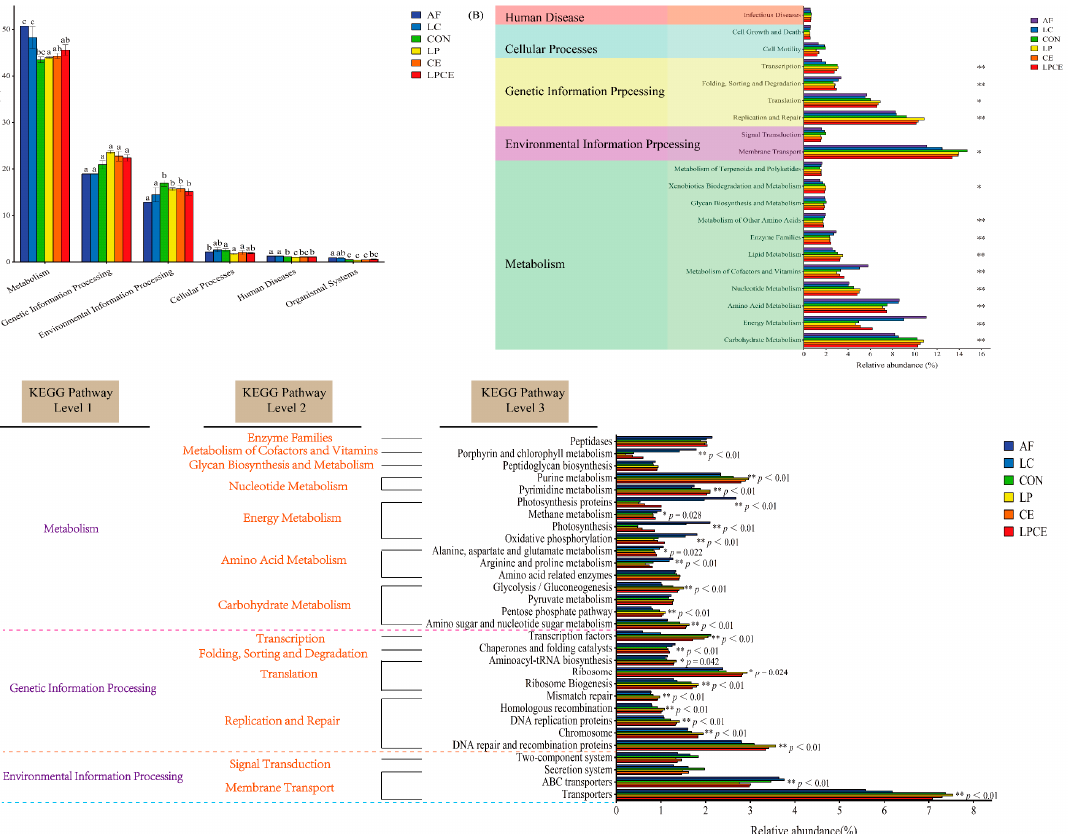
Figure 5. Dynamics of the bacterial functional profiles fed with different additives analyzed by PICRUSt2 ( n = 3). ( A ) Level 1 metabolic pathways; ( B ) Level 2 Kyoto Encyclopedia of Genes and Genomes (KEGG) ortholog functional predictions of the relative abundances of the top 20 metabolic functions; ( C ) Level 3 KEGG ortholog functional predictions of the relative abundances of the top 30 metabolic functions. CON, control silage, no additive; LP, silage containing Lactiplantibacillus plantarum ; CE, silage containing cellulase; LPCE, silage containing Lactiplantibacillus plantarum + cellulase. Different lowercase letters indicate significant differences among different treatments ( p < 0.05). Levels of significant are shown as follows: * p < 0.05; ** p < 0.01.